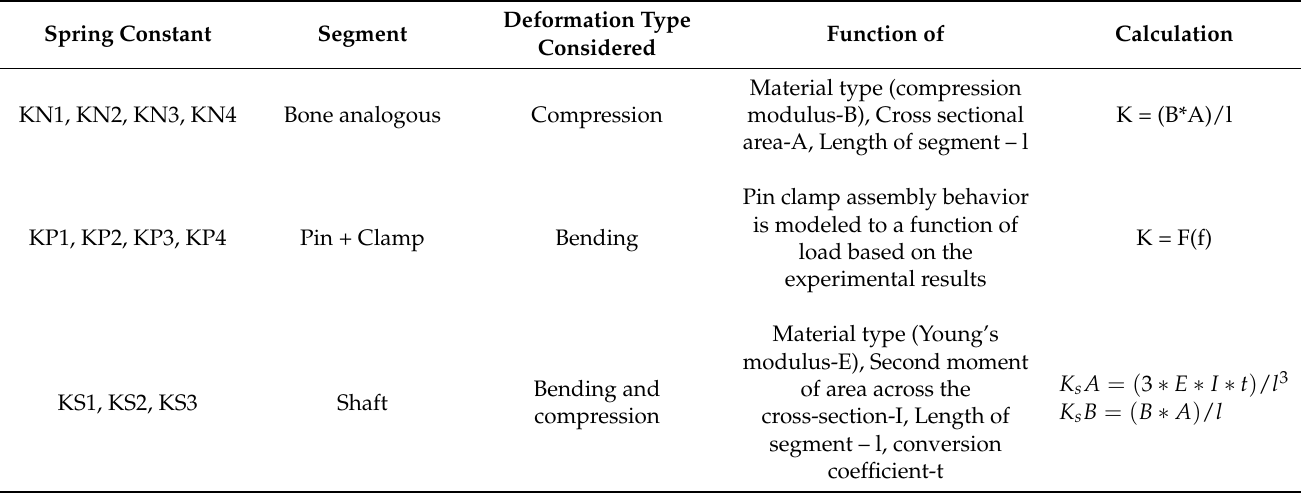
Table 3. Spring constants for each component segment.